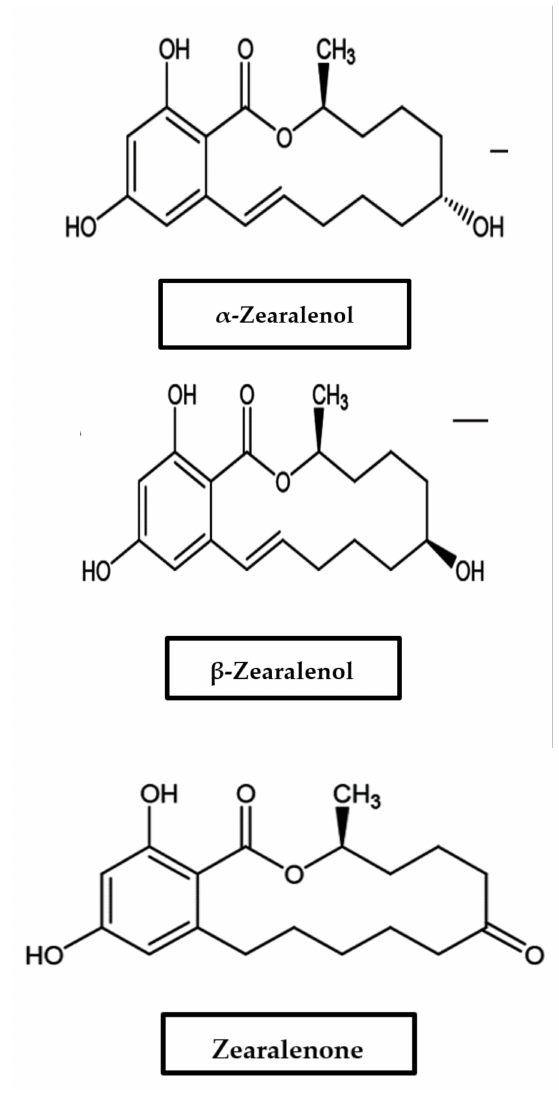
Figure 3. Chemical structure of zearalenone, α -zearalenol, and β